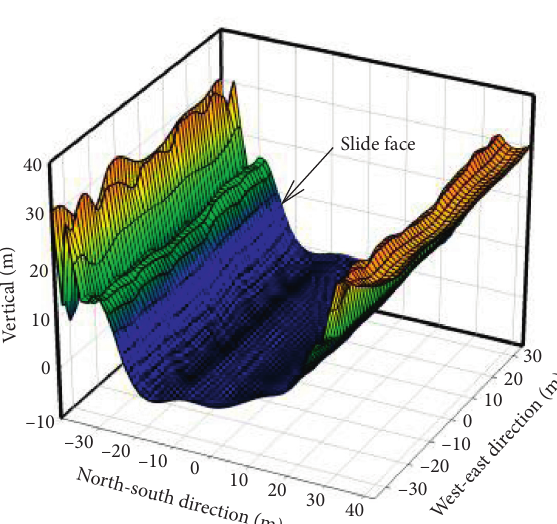
Figure 9: Three-dimensional shape of the slip surface.